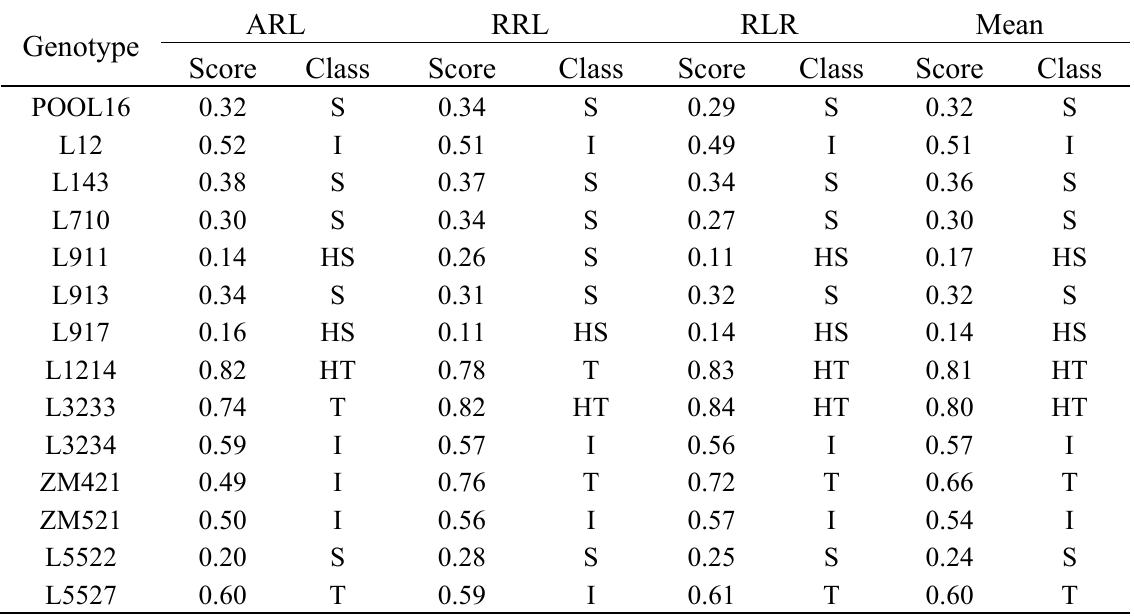
Table 9. Membership index for the 14 maize genotypes based on three selected root traits.*